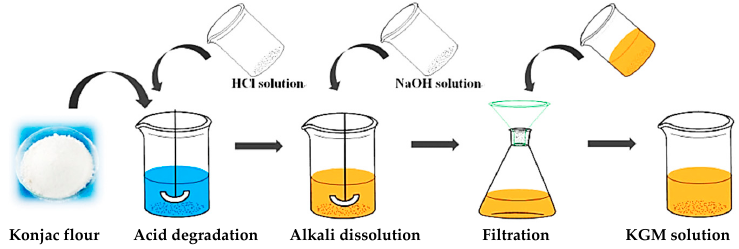
Figure 1. Scheme of the preparation of Konjac glucomanna (KGM) solution. Table 1. Konjac glucomanna (KGM) solutions with different viscosities.